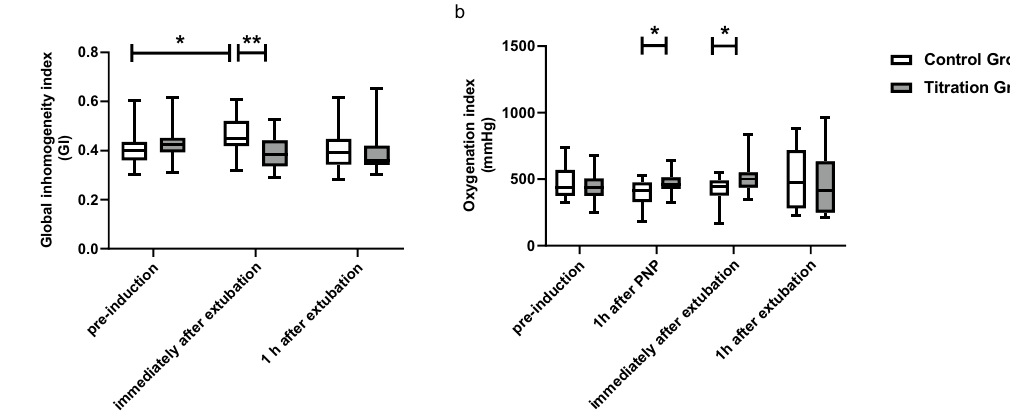
Figure 4. Box-whisker plots for the global inhomogeneity index ( a ) and oxygenation index ( b ) at different time points. Line at median, top of the box at the 75th percentile, bottom of the box at the 25th percentile, whiskers at the highest and lowest values. The oxygenation index was calculated as PaO 2 /FiO 2 . PNP, pneumoperitoneum. * p < 0.05; ** p < 0.01.